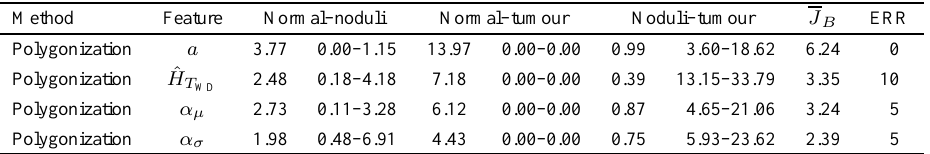
Estimated Bhattacharyya distances and lower and upper bounds of Bayes error (in %) for the best polygonization- based fractal features, ranked according to J B computed from Eq. (6)